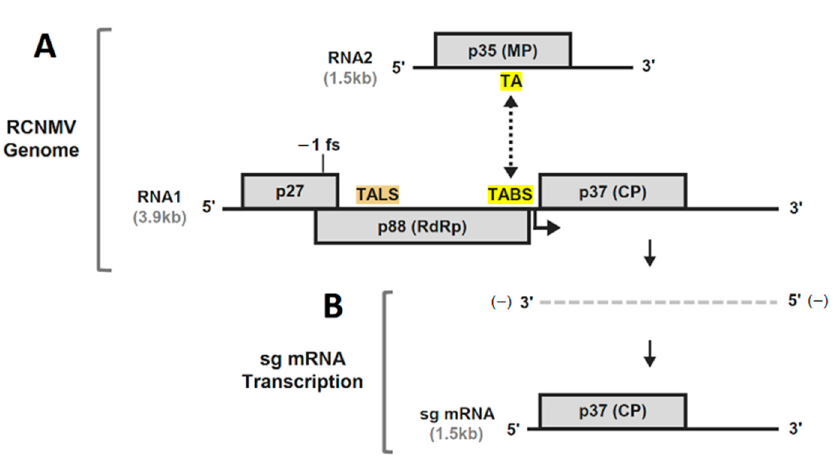
Figure 1. RCNMV genome organization and subgenomic mRNA synthesis. ( A ) Structures of RCNMV RNA1 and RNA2 genomes. Nucleotide lengths are shown in kilobases (kb). Encoded proteins are shown as grey boxes with their corresponding sizes indicated in kilodaltons. The positions of the TA in RNA2 and the TABS in RNA1 are highlighted in yellow, and the TALS in RNA1 is highlighted in tan. The black dashed arrow signifies the interaction between complementary TA and TABS sequences. The location of the transcription initiation site of the sg mRNA in RNA1 is indicated by the angled arrow. ( B ) Subgenomic mRNA transcription from RNA1. The trans -TA–TABS interaction functions as an attenuating RNA signal for premature termination during minus ( − )-strand synthesis of RNA1, resulting in a truncated ( − )-strand, shown as a grey dashed line, which then serves as the template for transcription of the subgenomic mRNA.